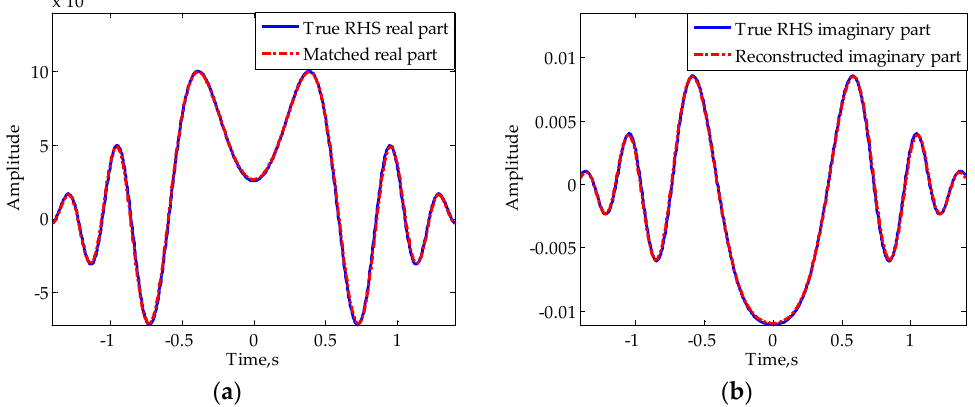
Figure 11. Results of ( a ) real part matching and ( b ) mainlobe RHS reconstruction. Solid lines represent true signals and dash-dotted lines represent constructed signals.